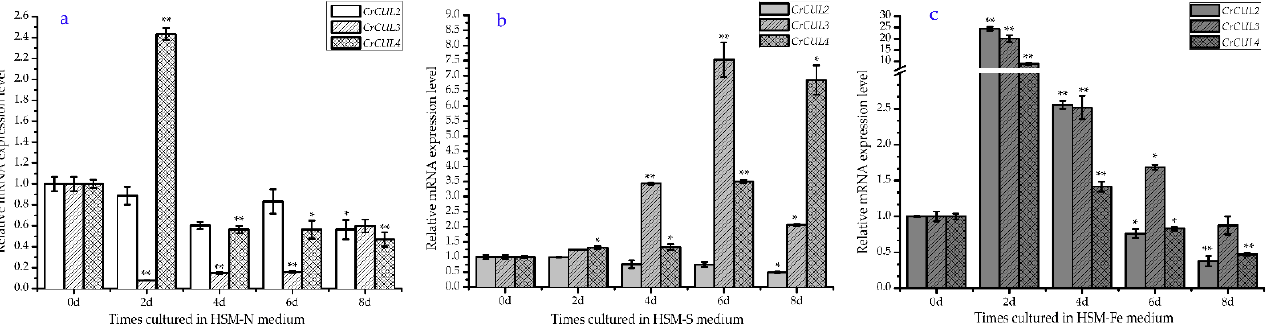
Figure 3. Expression patterns of CrCUL s in C. reinhardtii under deficiency stresses for eight days. The relative expression levels of CrCUL s under nutrition deprivation conditions including nitrogen ( a ), sulfur ( b ) and iron ( c ) deprivation were calculated. Each value represents the mean ± standard error (SE) of the three replicates. * and ** indicate significant differences p ≤ 0.05 and p ≤ 0.01, respectively, according to Dunnett’s analysis.